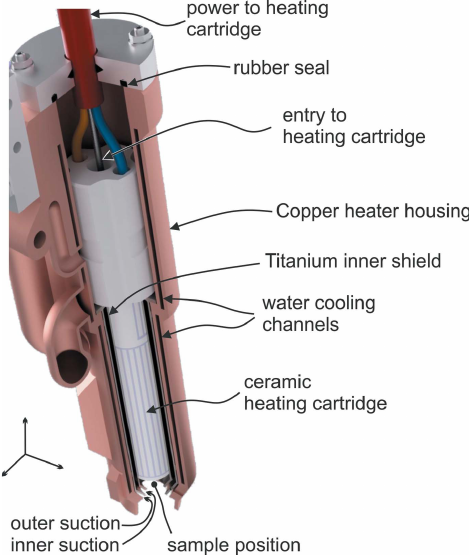
Figure 1 3D rendering of the heater nozzle. Arrows of the coordinate system correspond to 1 cm